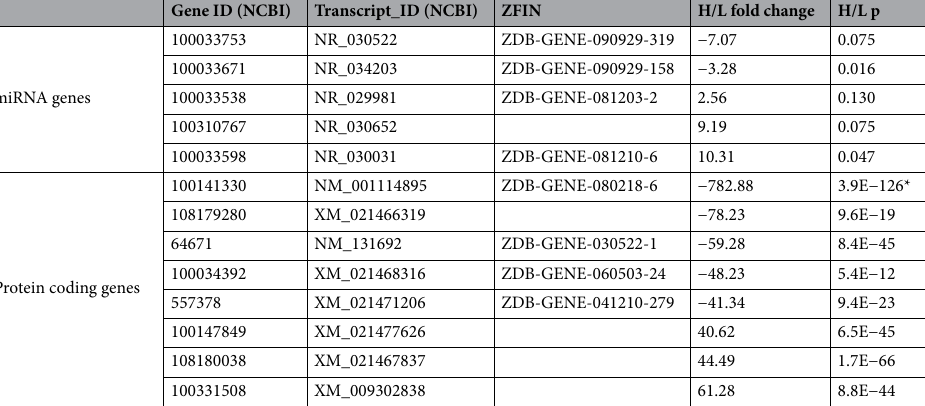
Gene ID (NCBI) Transcript_ID (NCBI) ZFIN H/L fold change H/L